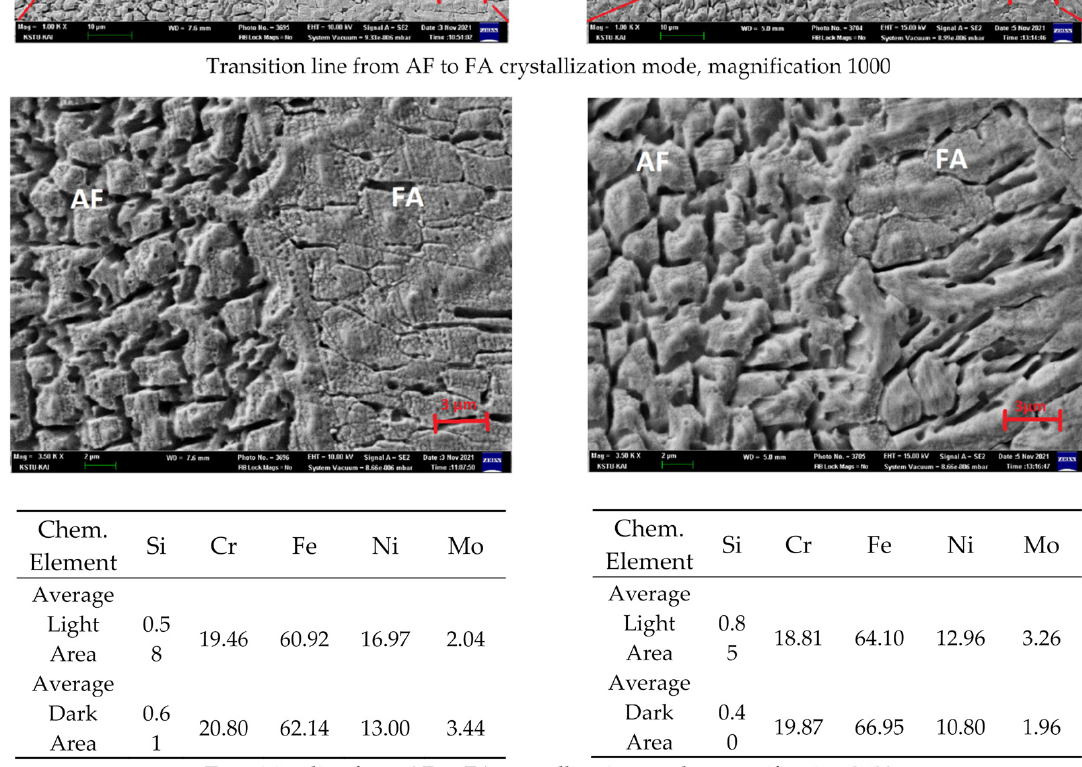
Figure 12. Microstructure and distribution of chemical elements of the middle part of the second pass (left NHT, right HT, magnification 350, 1000, and